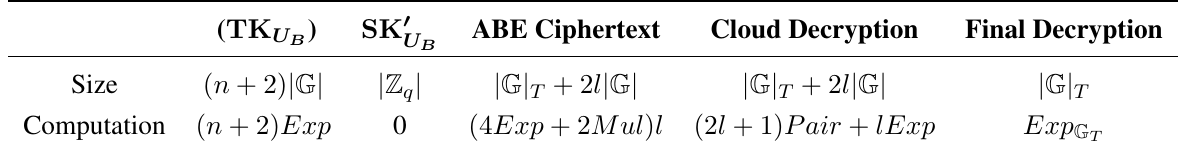
Table 3. The comparison of the computational overhead. ABE, attribute-based